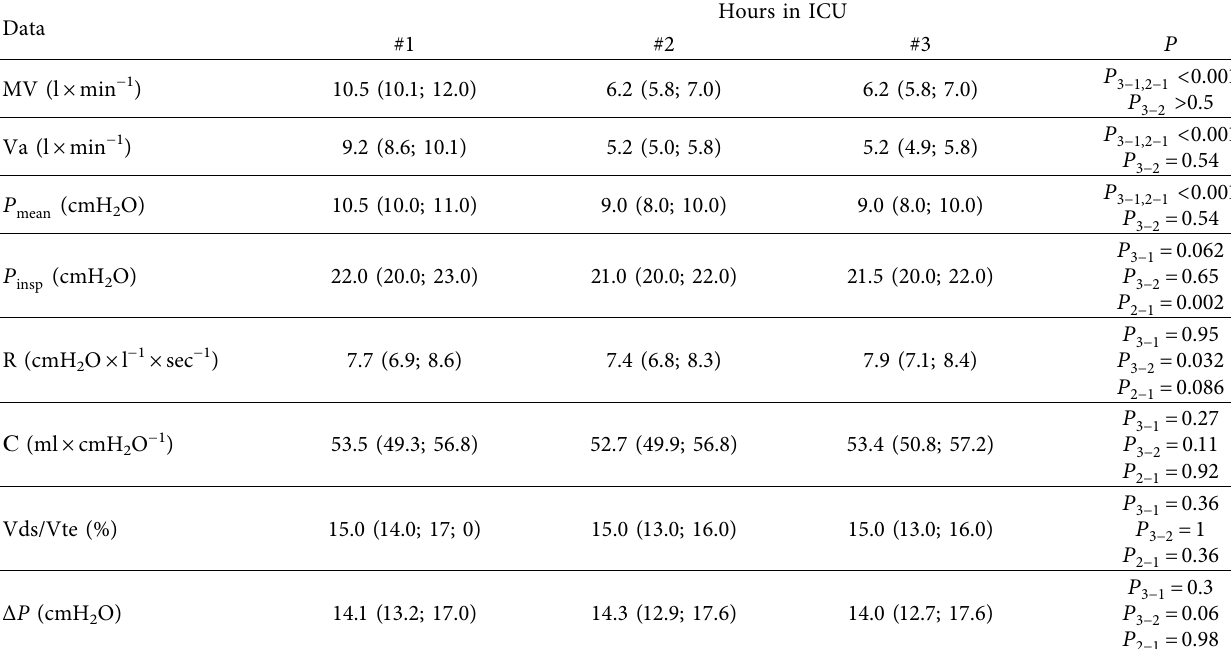
Table 4: Changes in respiratory mechanics data in patients from the control group at three hours of the study, median (25 th ; 75 th percentile), n �